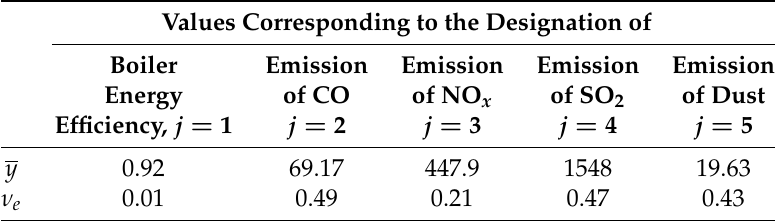
Table 3. Arithmetic mean values and random coefficient of